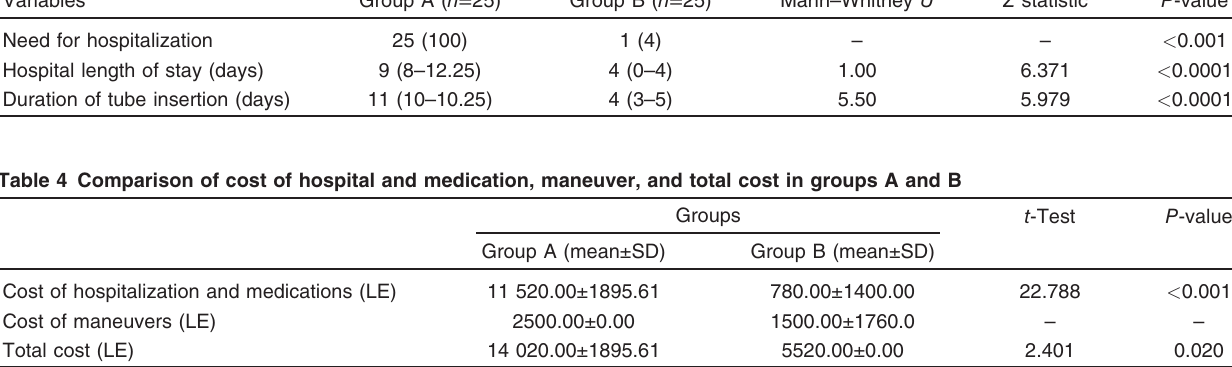
Table 3 Need for hospitalization, length of hospital stay, and duration of tube insertion in groups A and B Variables